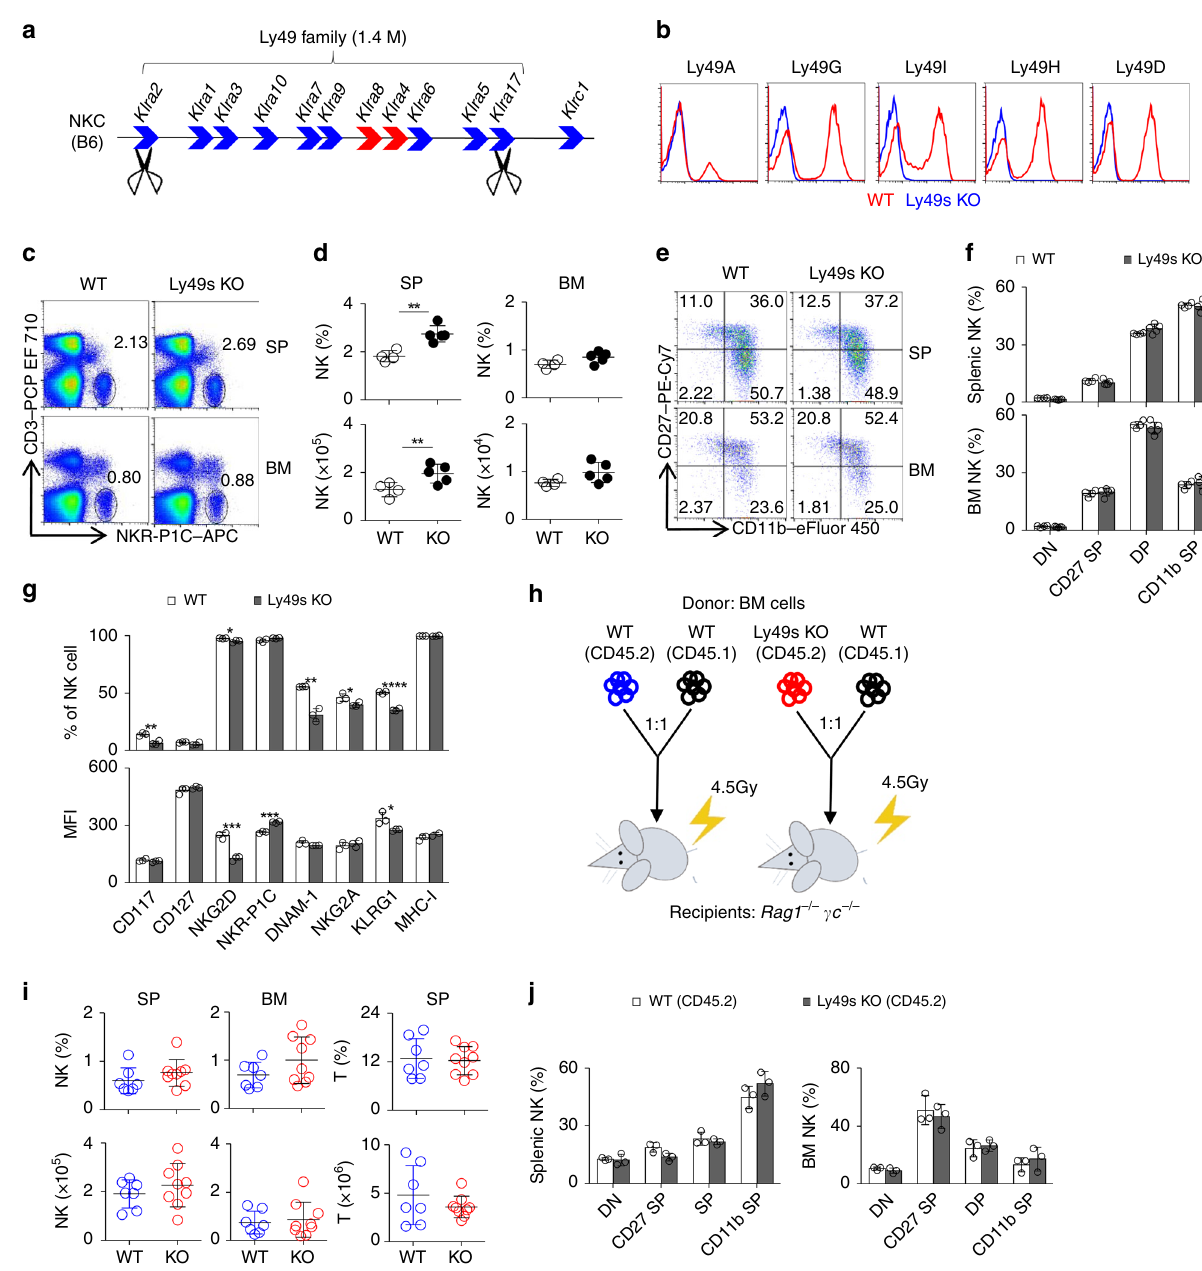
Fig. 1 Ly49 family is dispensable for NK-cell development. a Diagram of Ly49-family genes in the NKC locus. Blue fi lled arrows denote inhibitory receptors and red fi lled arrows denote activating receptors. Scissors represent CRISPR gRNAs. b Flow cytometry analysis of the expression of Ly49-family receptors on splenic NK cells (gated CD3 − NKR-P1C + ) from WT (red line) and Ly49s KO (blue line) mice. c , d Representative fl ow cytometry plots ( c ) and quanti fi cation ( d ) of NK cells (gated CD3 − NKR-P1C + ) in the spleen (SP) and bone marrow (BM) of WT and Ly49s KO mice. e , f Representative fl ow cytometry plots ( e ) and percentages ( f ) of gated CD3 − NKR-P1C + NK cells in the four stages of development, including DN (CD27 − CD11b − ), CD27 SP (CD27 + CD11b − ), DP (CD27 + CD11b + ) and CD11b SP (CD27 − CD11b + ), in the spleen and BM from WT and Ly49s KO mice. g The percentage and mean fl uorescence index (MFI) of the indicated molecules in gated splenic CD3 − NKR-P1C + NK cells except NKR-P1C and NKp46 in gated splenic CD3 − CD122 + NK precursor cells from WT and Ly49s KO mice. h Experimental design of bone marrow chimera assay. i Quanti fi cation of NK cells (gated CD45.2 + CD3 − NKR-P1C + ) and T cells (CD45.2 + CD3 + NKR-P1C − ) in the spleen and BM from chimeric recipient mice (7 – 9 mice pooled from two independent experiments). j Percentages of four NK-cell subsets (gated CD45.2 + CD3 − NKR-P1C + ) NK cells in the spleen and BM from chimeric recipient mice. Each symbol represents an individual mouse. Data shown represent two ( j ) or at least three ( c – g ) independent experiments. Mean± SD is shown. * p < 0.05, ** p < 0.01, *** p < 0.001 and **** p < 0.0001. Unpaired Student ’ s t -tests (two-tailed) was used to calculate these values. Source data are provided as